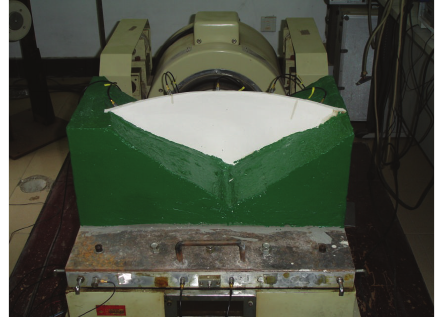
Figure 1: Arch dam model with base-excitation